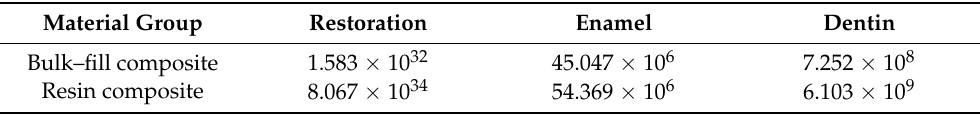
Table 5. Estimated number of cycles required for fracture of dental materials and dental tissues as a result of